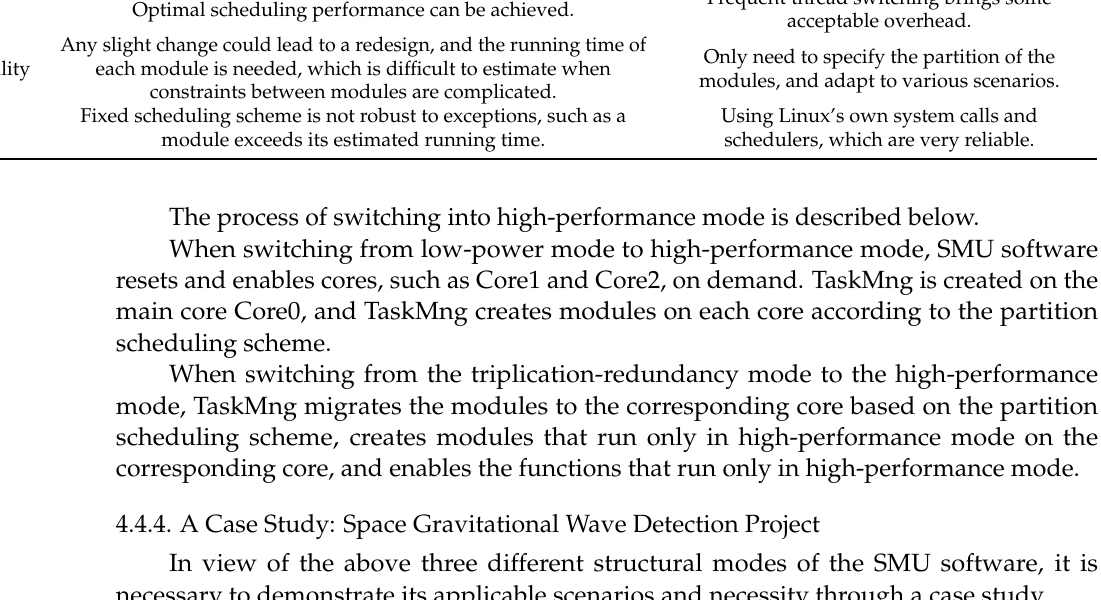
Table 3. Feature comparison between our scheduling method and static scheduling. Static Scheduling Ours